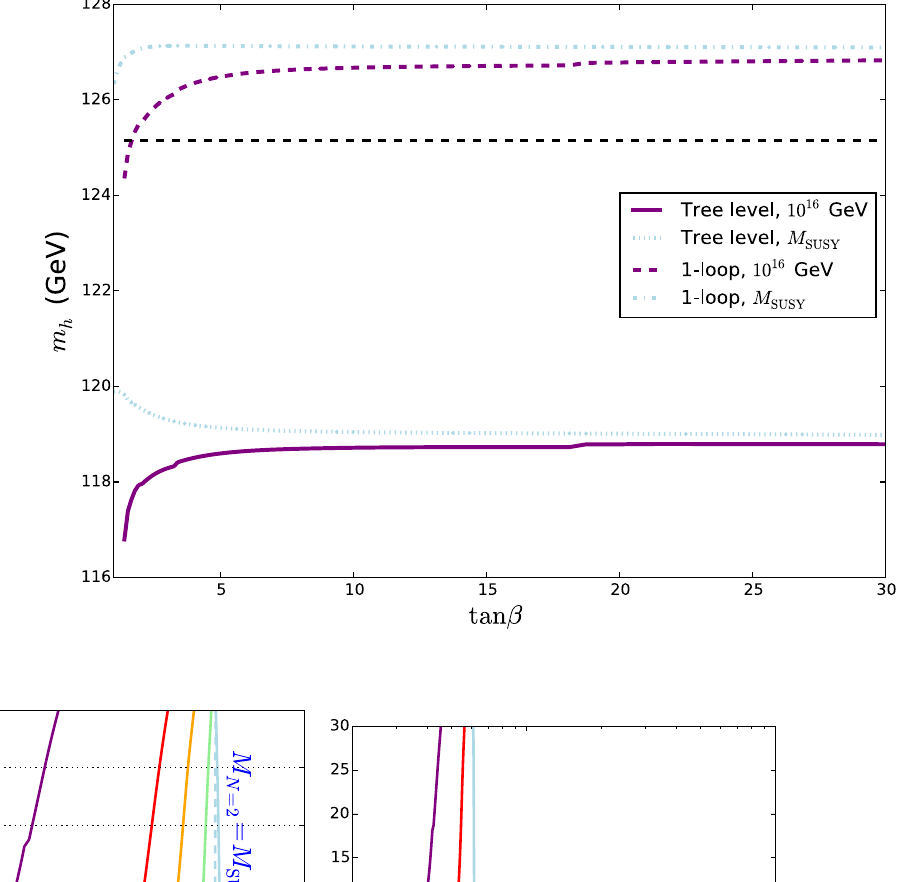
Fig. 5 Effect of loop corrections in the low-energy theory on the Higgs mass. The tree-level and one-loop values for the Higgs mass are shown against tan β for N = 2 scales of the stop scale ( M SUSY ) and 10 16 GeV; the two-loop value of the Higgs mass is fixed to the black dotted line